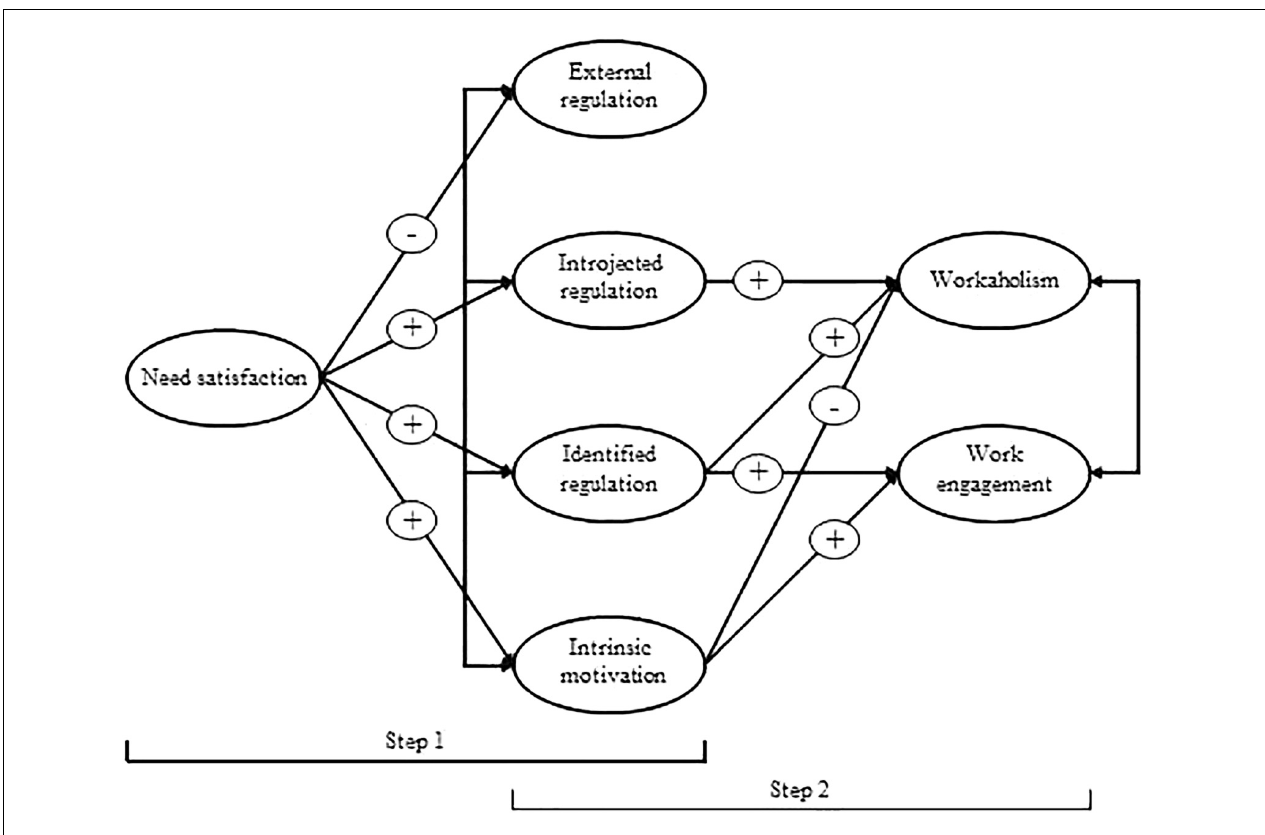
FIGURE 1 | Model for the relationships among need satisfaction, regulatory styles, workaholism, and work